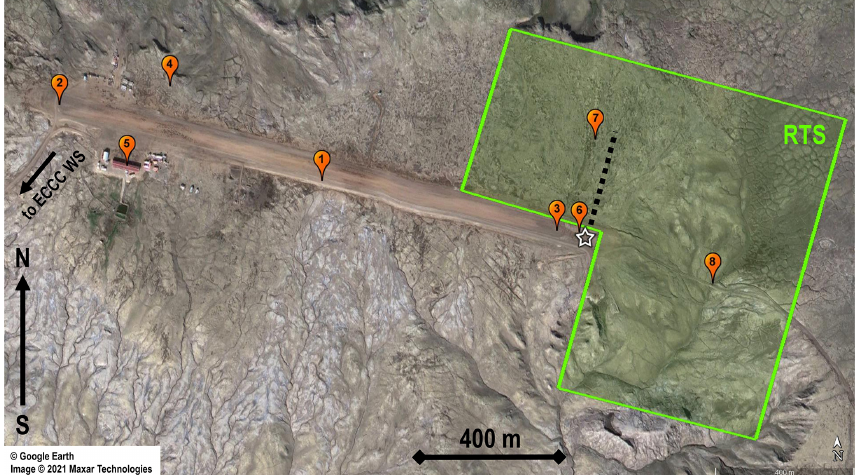
Figure 4. The Runway Test Site (RTS) – a flight region near the Eureka Aerodrome and NOAA flux tower. Pins in the figure indicate the locations of the Eureka Aerodrome – no. 1, west side of the runway – no. 2, east side of the runway – no. 3, Eureka A weather observing site – no. 4, Fort Eureka buildings – no. 5, temperature profile measured by M100 on 28 February 2017 – no. 6, NOAA flux tower – no. 7, and gully – no. 8 (see further details in the text). The black dotted line represents a typical ground track of M210 RTK during measurements of the vertical temperature profiles near the flux tower in March 2020. The drone take-off and landing pad is marked by a star symbol.